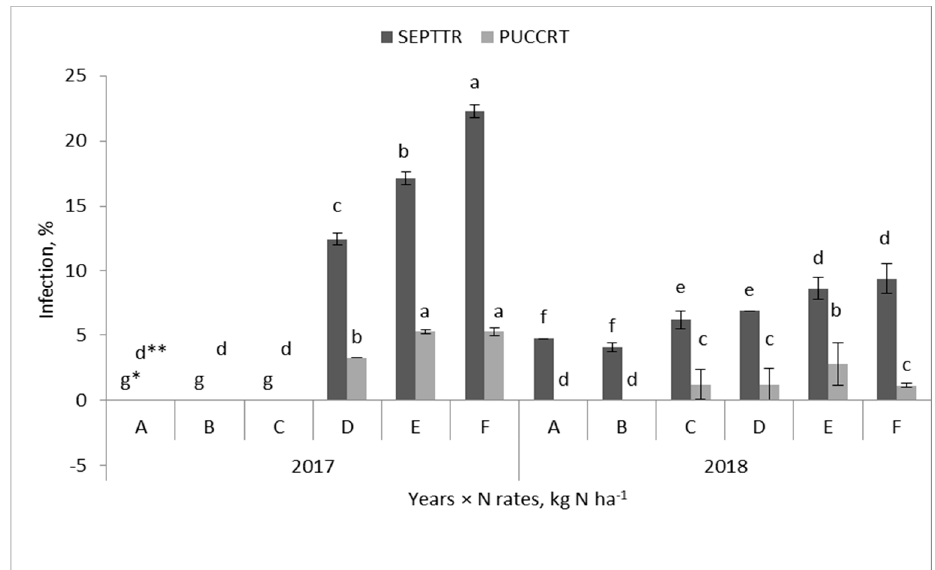
Figure 5. Effect of plant protection methods on infestation of winter wheat by pathogens. Similar letters indicate a lack of significant differences between experimental treatments using Tukey’s test. The vertical bar in the column is the standard error of the mean. g*, d**—no infection for SEPTTR and PUCCTR,